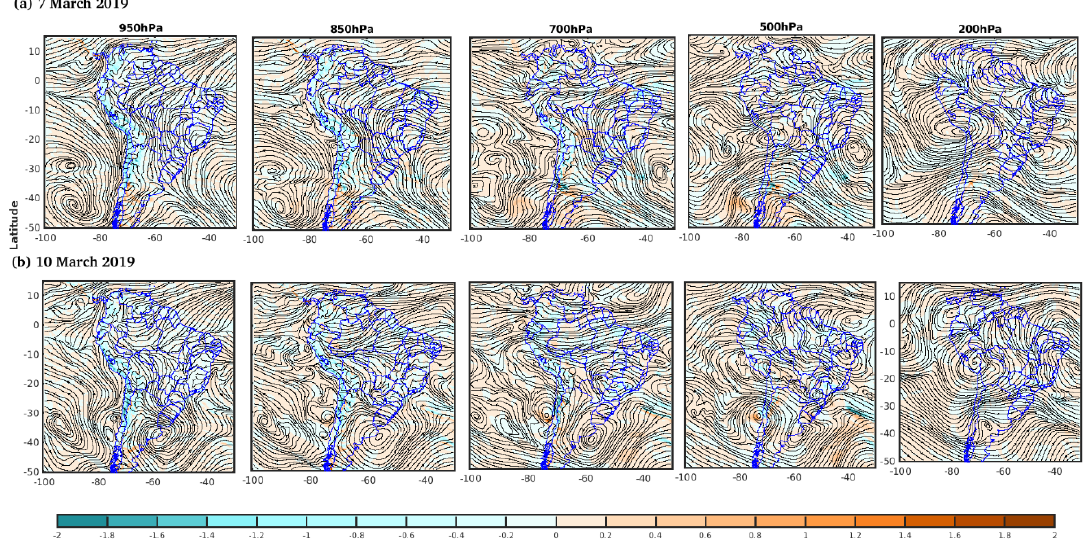
Figure 11. Wind streamlines (m s − 1 ) and vertical velocities (Pa s − 1 ) at high levels (700 hPa) at 18 UTC for three dates. Positive (negative) values indicate downdraft (updraft) winds. All composites data were obtained for the three convective events at 1800 UTC from the GFS reanalysis data (resolution: 1 ◦ ). The colorbar in Pa s − 1 .